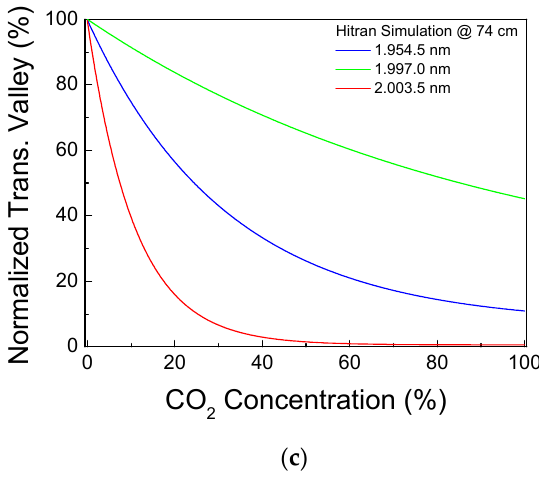
Figure 2. ( a ) Transmittance around 2003.5 nm for CO 2 concentrations of 5% and 20% across a 74 cm long cavity at total pressure of 1 atm; ( b ) normalized transmission; ( c ) normalized transmission valley as a function of CO 2 concentration.